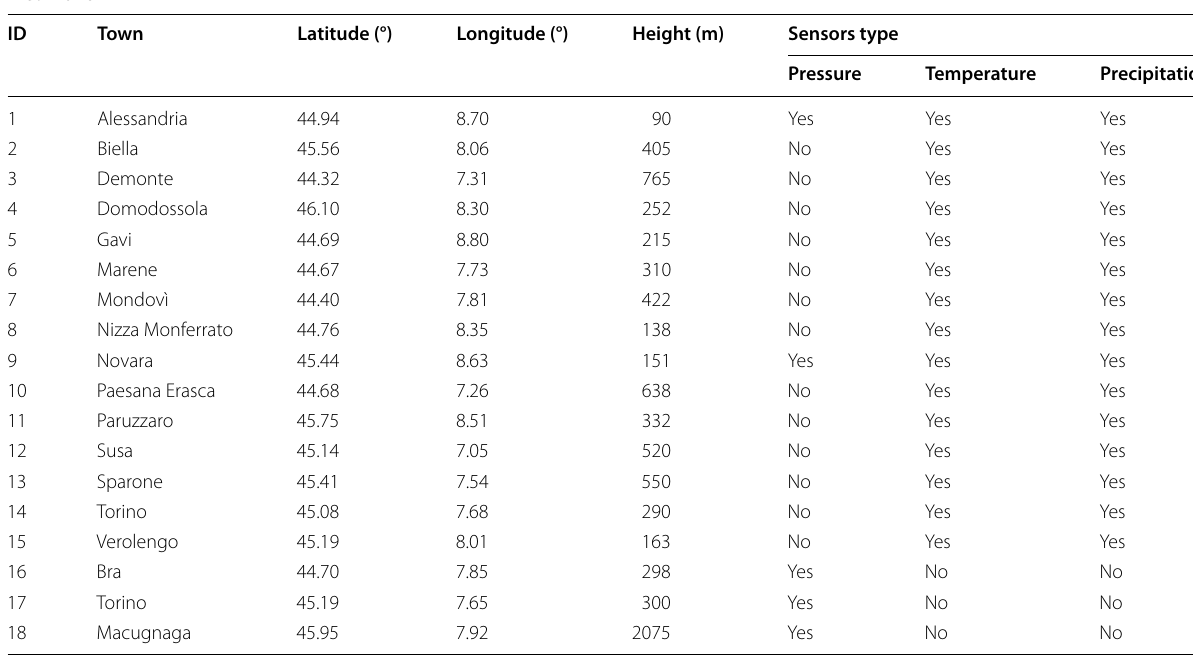
Table 4 Details for the Piedmont weather station